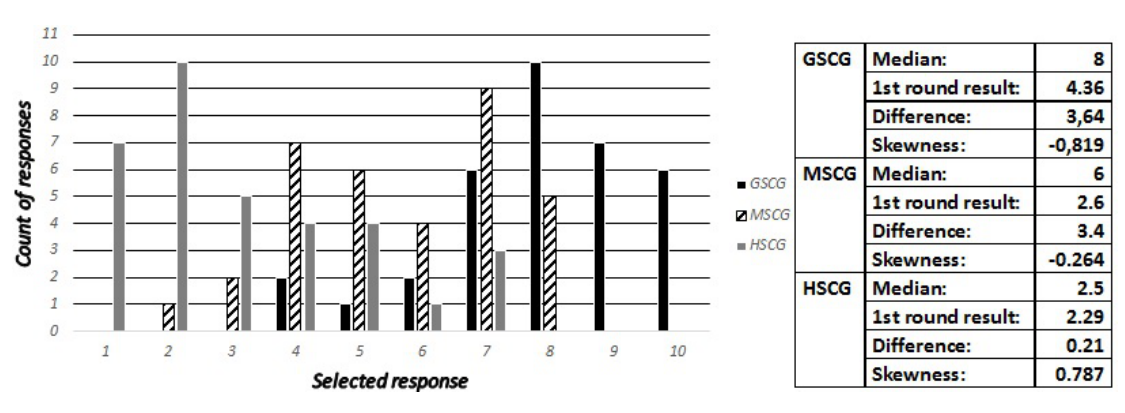
Figure 9. Expert predictions for question 7.